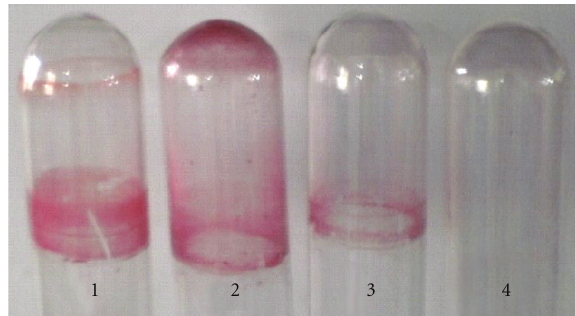
Figure 4: Qualitative assay showing biofilm formation on abiotic (glass) surface. biofilms formed by 1: A. baumannii AIIMS 7, 2: E. coli DH5 α -pGEpmt , 3: E. coli DH5 α -pGEM, 4: negative control (LB broth).